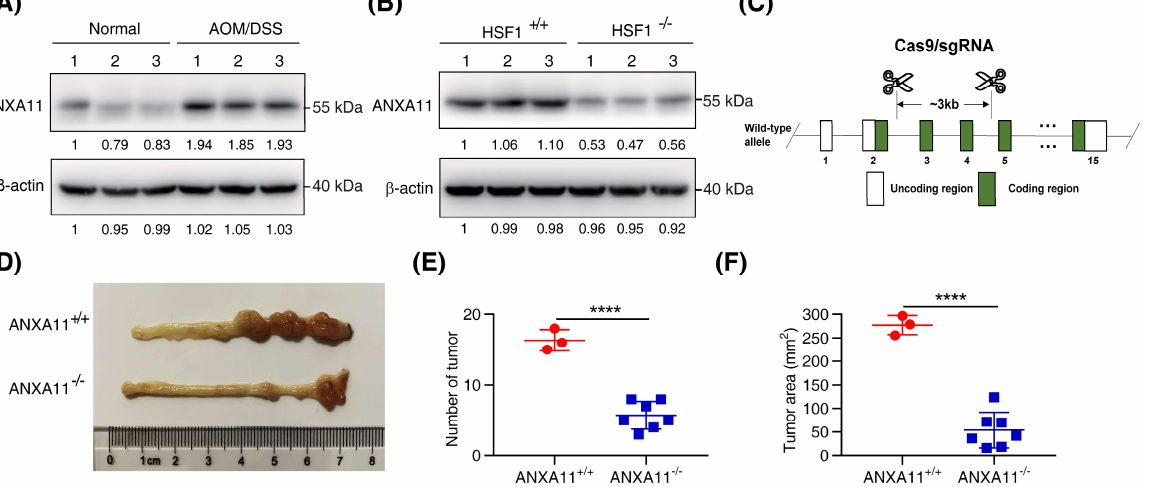
Figure 7. Knockout of ANXA11 attenuated CRC carcinogenesis in vivo. ( A ) Expression of ANXA11 protein in azoxymethane (AOM)/dextran sulfate sodium (DSS)–treated mice compared with normal mice. ( B ) Expression of ANXA11 protein in AOM/DSS–treated mice after HSF1 knock- out. ( C ) Schematic digraphs depicting the CRISPR/Cas9-mediated ANXA11 knockout strategy. ( D ) Representative images of ANXA11 +/+ and ANXA11 −/− mice colon and rectum. ( E ) Assessment of the number of tumors of ANXA11 +/+ and ANXA11 −/− mice. ( F ) Assessment of the tumor area of ANXA11 +/+ and ANXA11 −/− mice. ( G ) The overall survival of ANXA11 +/+ and ANXA11 −/− mice. ( H ) The body weight of ANXA11 +/+ and ANXA11 −/− mice. ( I ) Representative HE (hematoxylin–eosin) staining and IHC (immunohistochemistry) staining of Ki67 and ANXA11 from the ANXA11 +/+ and ANXA11 −/− mice colorectal tissues (scale bar, 20 µm). ( J ) Working model. All data represent the mean ± SD, n ≥ 3. **** p < 0.0001. 4. Discussion The accumulating evidence has suggested that HSF1 exerts a multifaced feature in tumorigenesis [37]. Recent studies have demonstrated that HSF1 expression is negatively correlated with immune checkpoint genes’ expression [38], tumor mutational burden (TMB), and microsatellite instability (MSI) in CRC [39], implying no reaction to immuno- therapy when HSF1 is highly expressed. Therefore, it may be theoretically feasible to